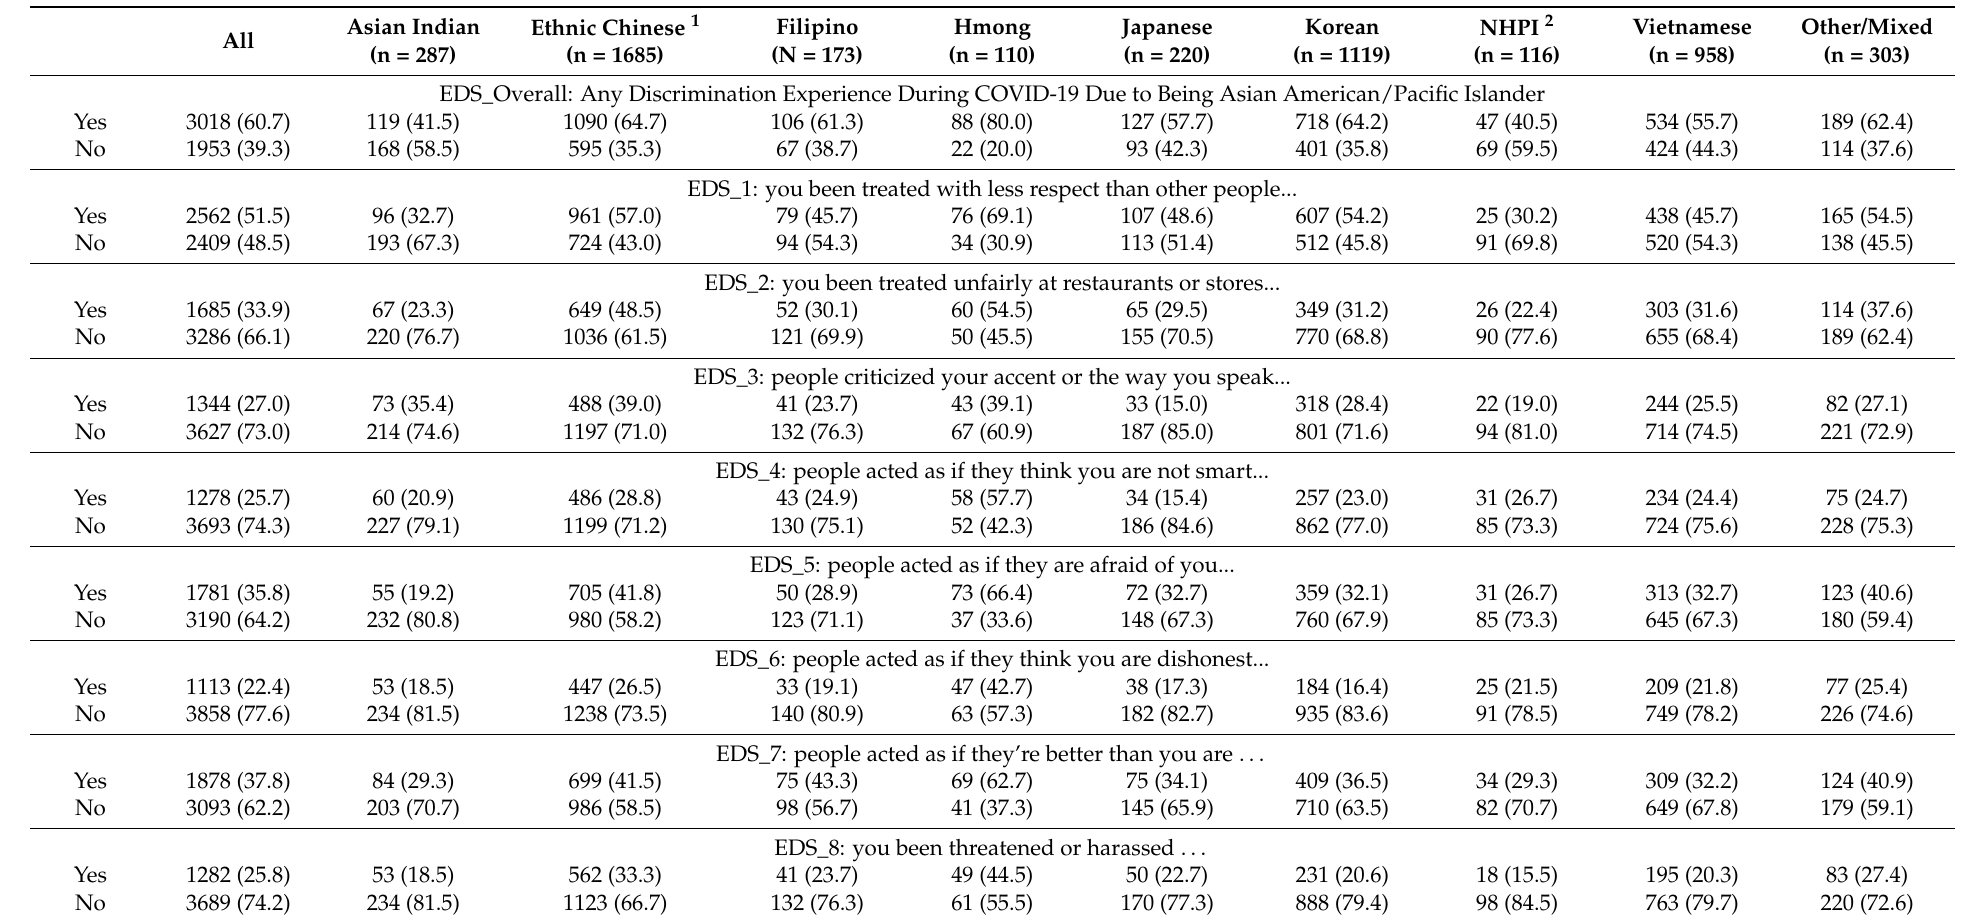
Table 2. Experiences of discrimination during the COVID-19 pandemic due to being Asian, Asian American or Pacific Islander by cultural group: N